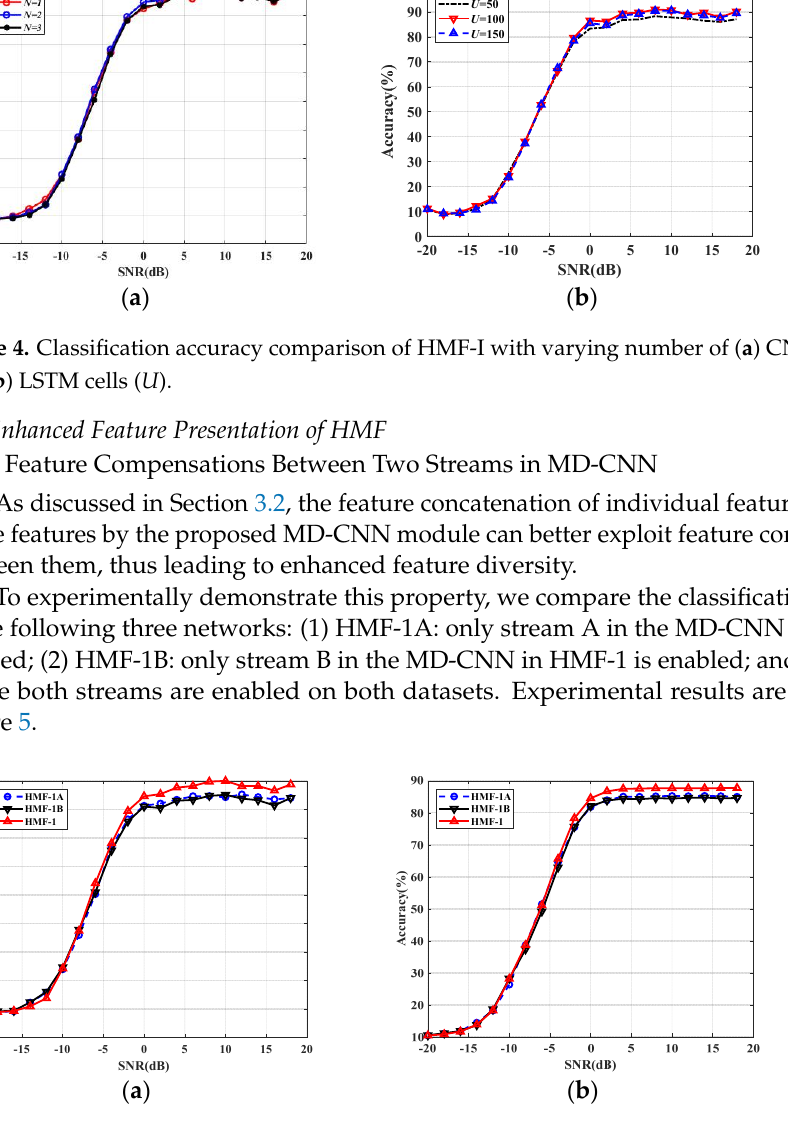
Figure 4. Classification accuracy comparison of HMF-I with varying number of ( a ) CNN layers ( N ) and ( b ) LSTM cells ( U ).